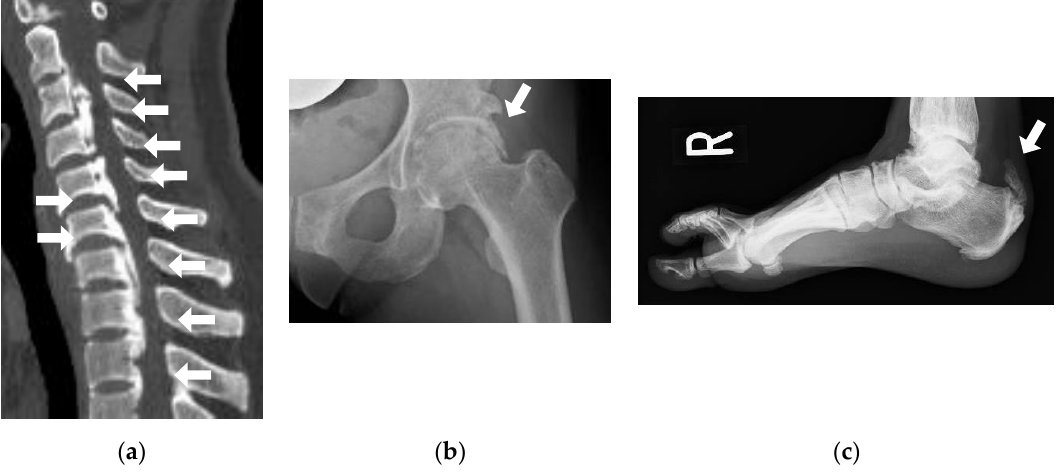
Figure 2. Enthesopathies in adult XLH patients. ( a ) Severe ossification of the posterior longitudinal ligament and ossification of the anterior longitudinal ligament presented in an adult XLH patient. ( b ) A large osteophyte developed around the left hip joint in an adult XLH patient, causing severe impingement syndrome. ( c ) Enthesopathy developed in the right Achilles tendon in an adult XLH patient.